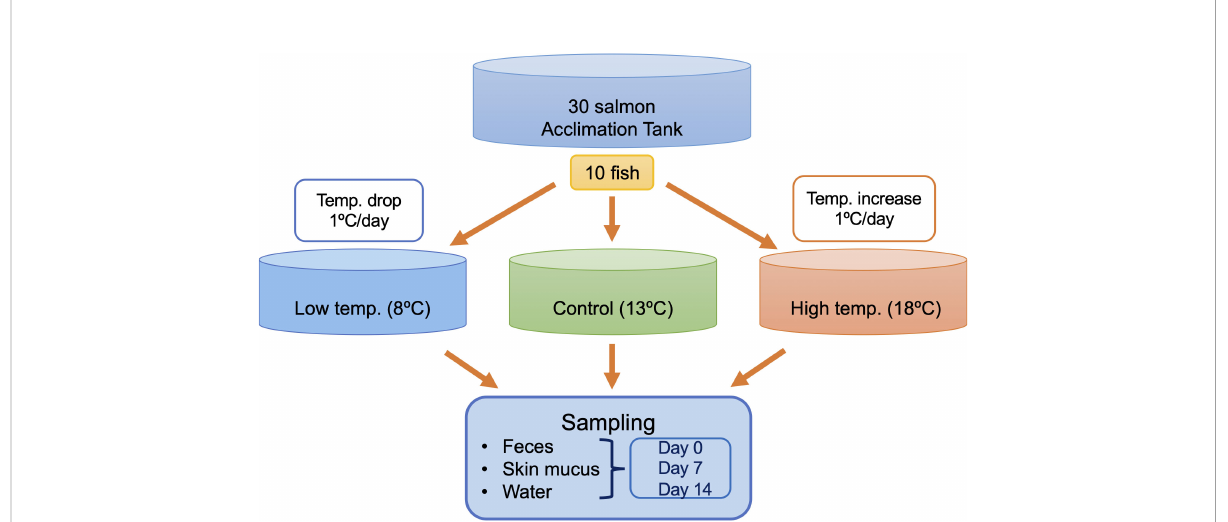
FIGURE 1 Schematic illustration of the experimental design. A total of 30 fi sh were used in this experiment, including 10 in each of the control, low- temperature, and high-temperature tanks. Feces, skin mucus, and surrounding water were sampled in triplicates from each tank during each sampling point on Days 0, 7, and